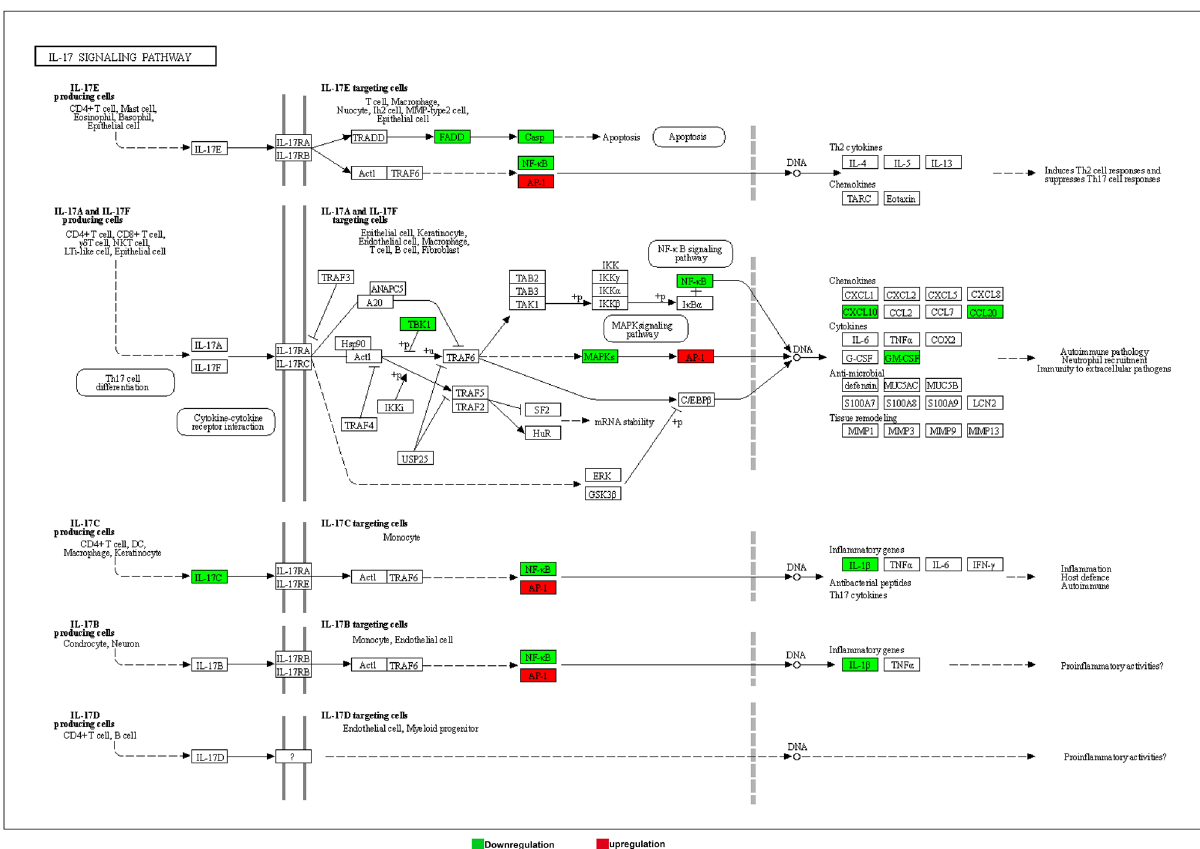
Figure 4. IL-17 signaling pathway. Down- and up-regulations are marked with green and red colors, respectively. Samples are from 3 recurrent COVID-19 patients and 3 healthy